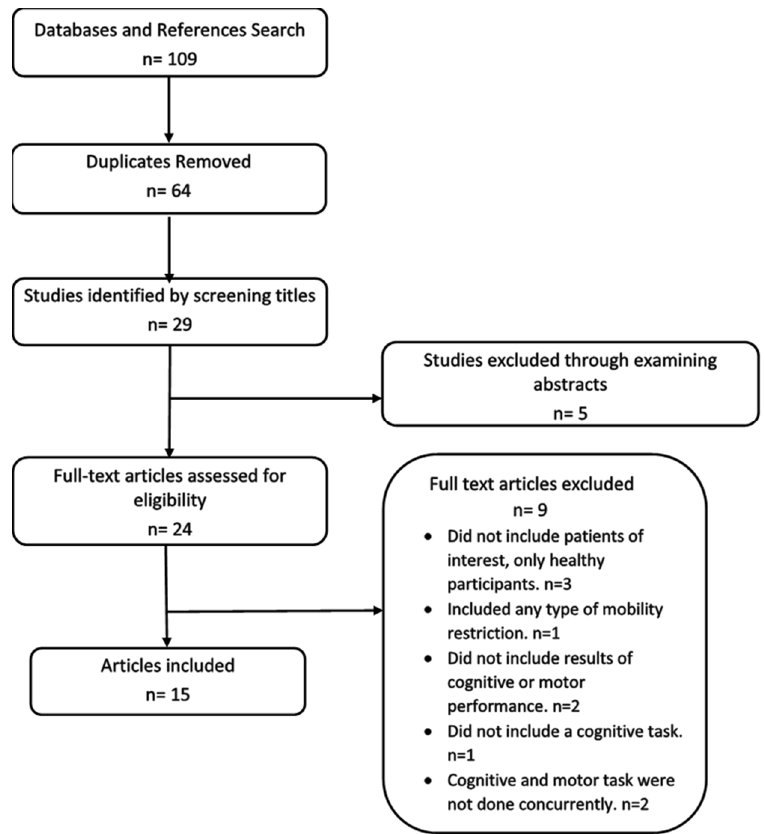
Figure 1. Flowchart showing the process of study